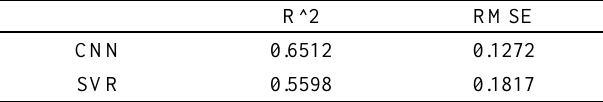
Table 2. The RMSE and R^2 of CNN and